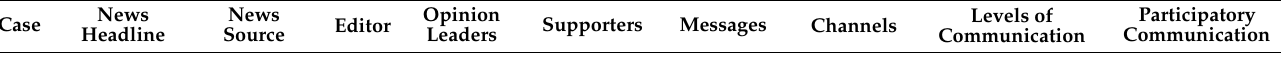
Table 1. Table 1. Coding form of food security news on the Internet (World Wide Web). Table 1. Coding form of food security news on the Internet (World Wide Web).